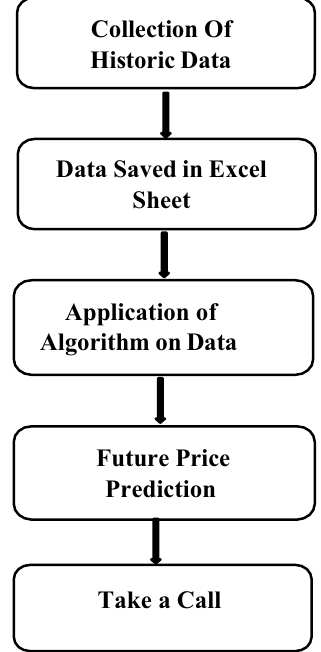
Fig. 1. Formulation and